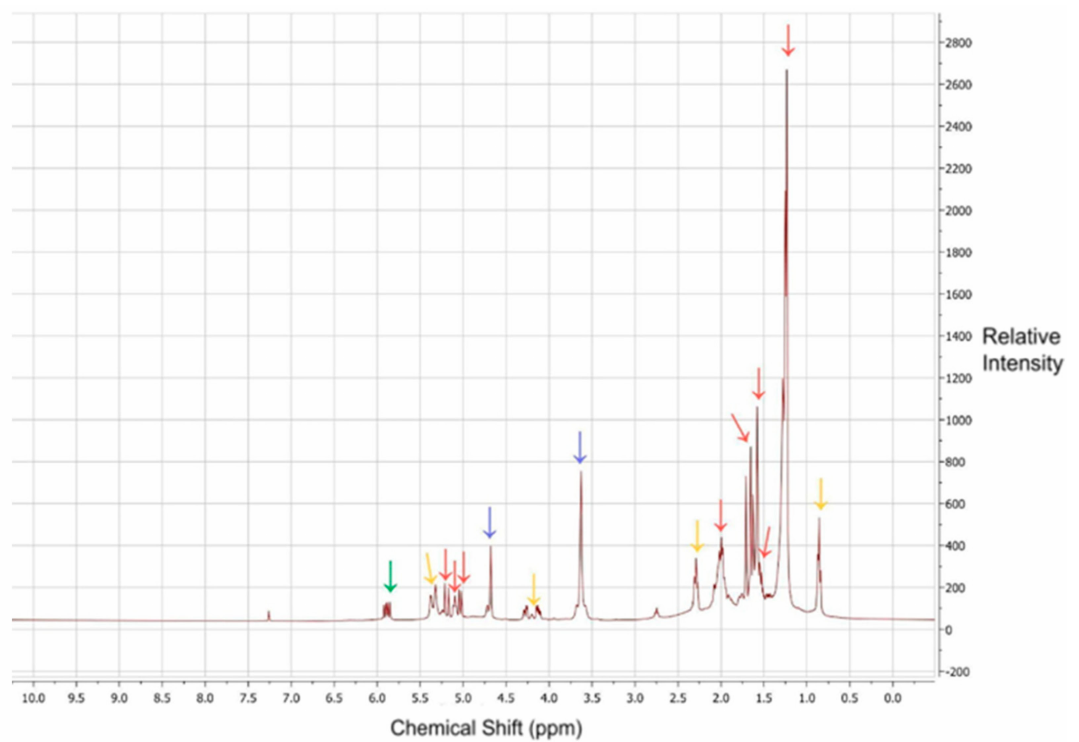
Figure 2. NMR spectra for sample 1. The green arrow indicates peaks for potential dehydration products, red arrows indicate peaks for ( R )-linalool, blue arrows indicate peaks for polysorbate 20 and yellow arrows indicate peaks for triglycerides and similarly unsaturated fatty